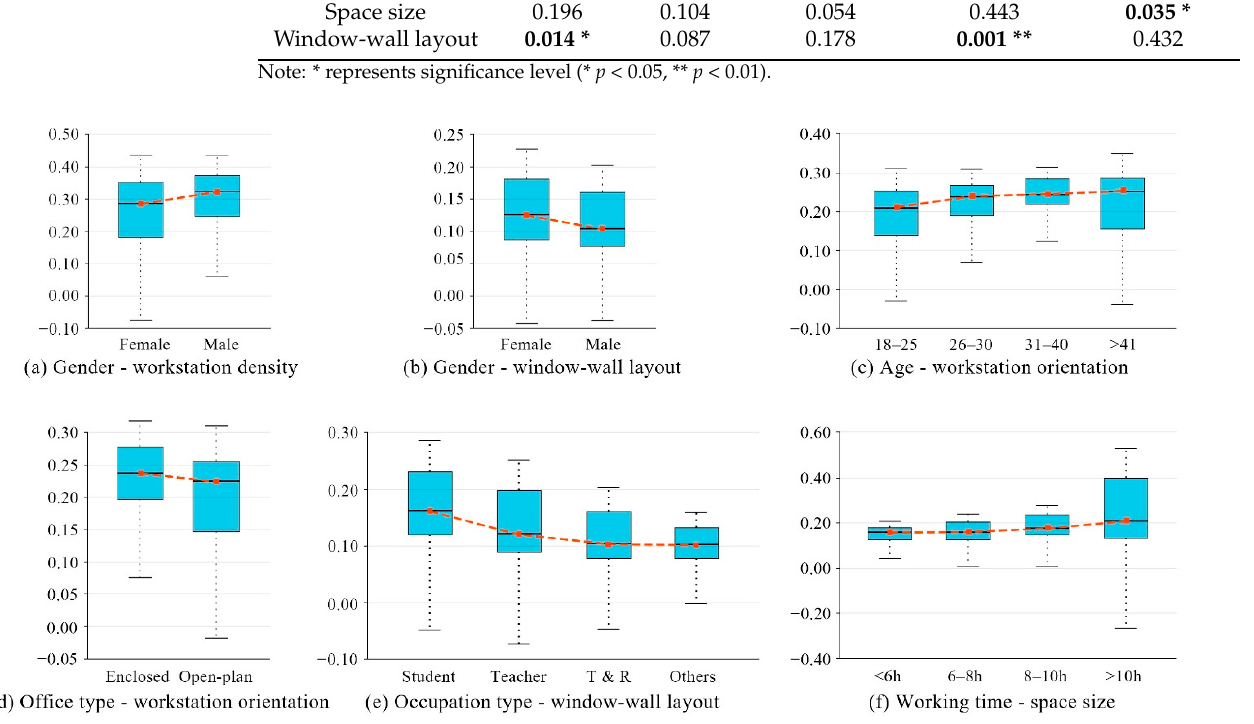
Figure 5. Important weight distribution of the office layout factors in significant